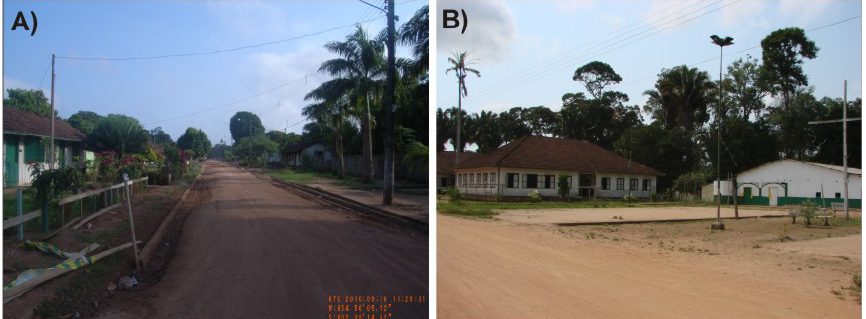
Figure 6. Spatial patterns verified within the units of human occupation that were categorized as Established: ( A ) occupation of Belterra; ( B ) American-style building-the school at Vila